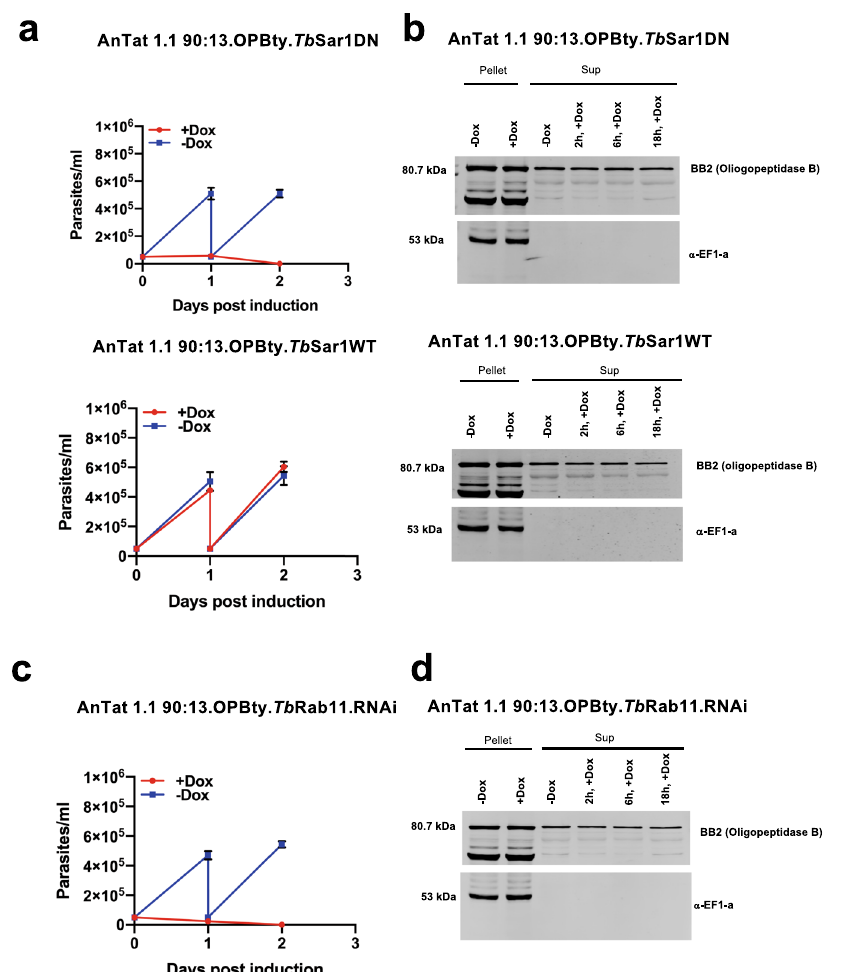
Fig. 7 Oligopeptidase B exhibits unconventional protein secretion. a Growth in vitro (mean ± SEM) of T. brucei AnTat1.1 90:13 constitutively expressing epitope tagged Tb927.11.12850 (oligopeptidase B), induced to express dominant-negative SAR1 (upper panel) or wild type SAR1 (lower panel)( n = 2 in biologically independent analyses). Expression of the dominant-negative SAR1 induced growth cessation within 24 h. b Extracellular release of epitope tagged Tb927.11.12850 from parasites induced to express dominant-negative SAR1 (upper panel) or wild type SAR1 (lower panel). Tb927.11.12850 was released at equivalent levels in each case (with an additional degradation product in the pellet fractions only), whereas the cytosolic control EF1-alpha remained cell associated. c Growth in vitro (mean ± SEM) of T. brucei AnTat 1.1 90-:13 constitutively expressing epitope tagged Tb927.11.12850,